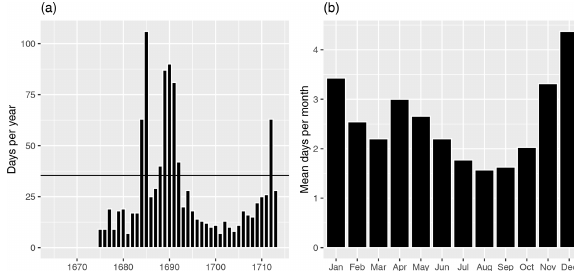
Figure A1. In panel (a) the total number of days when the evening temperature exceeds the midday/afternoon temperature is shown. The black horizontal line represents the mean value of the ERA5 data from 1981 to 2010. In panel (b) the frequency of days when the evening temperature exceeds the midday/afternoon temperature (per month) is